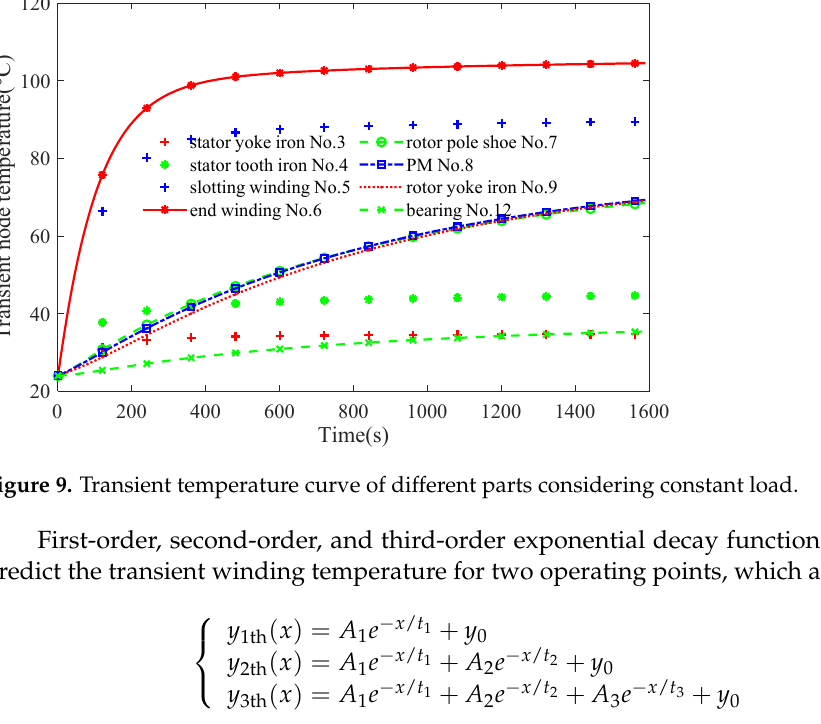
where y 0 is the offset distance; A 1 ~ A 3 are amplitude; t 1 ~ t 3 are the decay constant. The parameters of three kinds of exponential decay functions are calculated by origin as shown in Table 7. Table 7. Loss value of IPMSM parts.